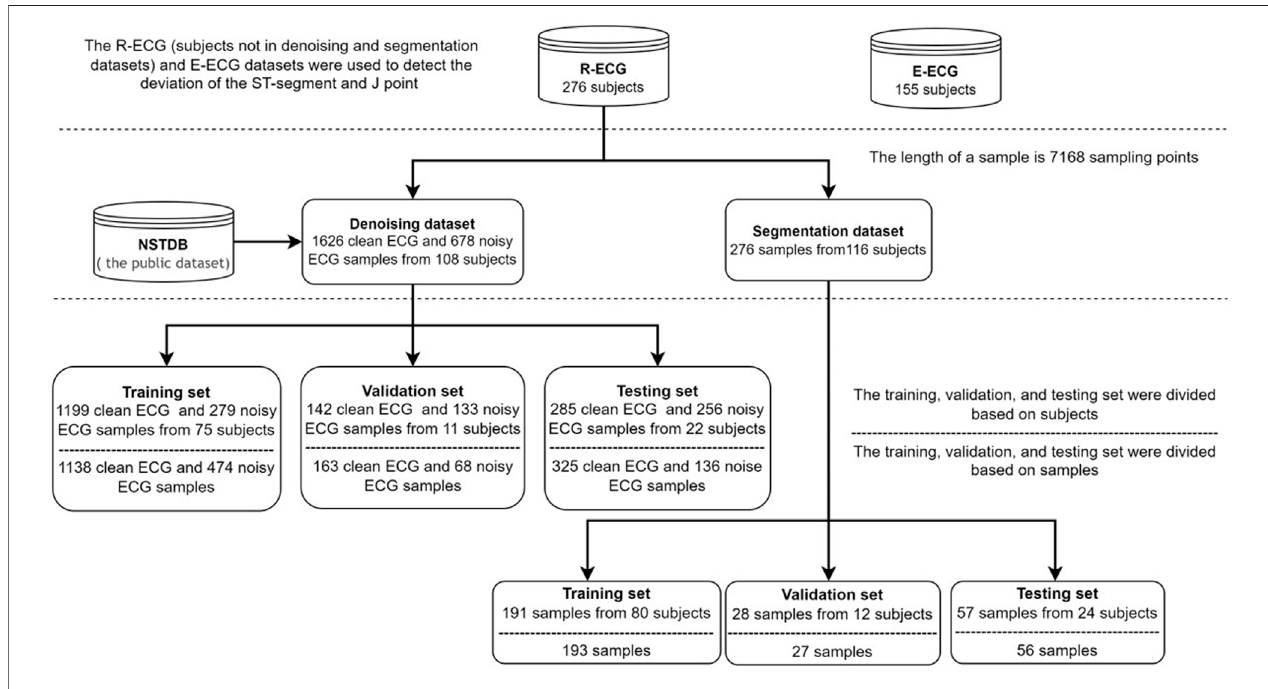
FIGURE 5 | The structure of our